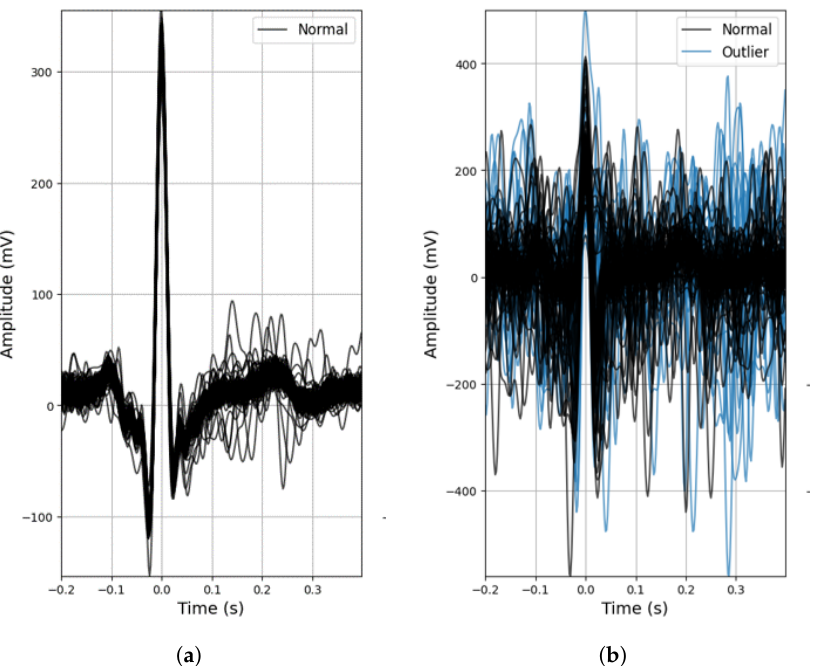
Figure 6. Examples of outlier detection using the DBSCAN method: ( a ) Participant 4, acquisition no. 18; ( b ) Participant 5, acquisition no. 19.